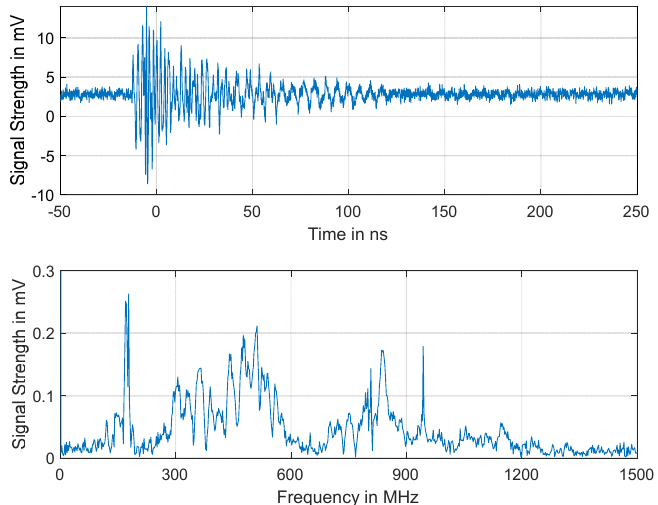
Figure 13. Time ‐ domain signal and frequency spectrum of the same signal obtained from sensor 1. Figure 13. Time-domain signal and frequency spectrum of the same signal obtained from sensor 1.